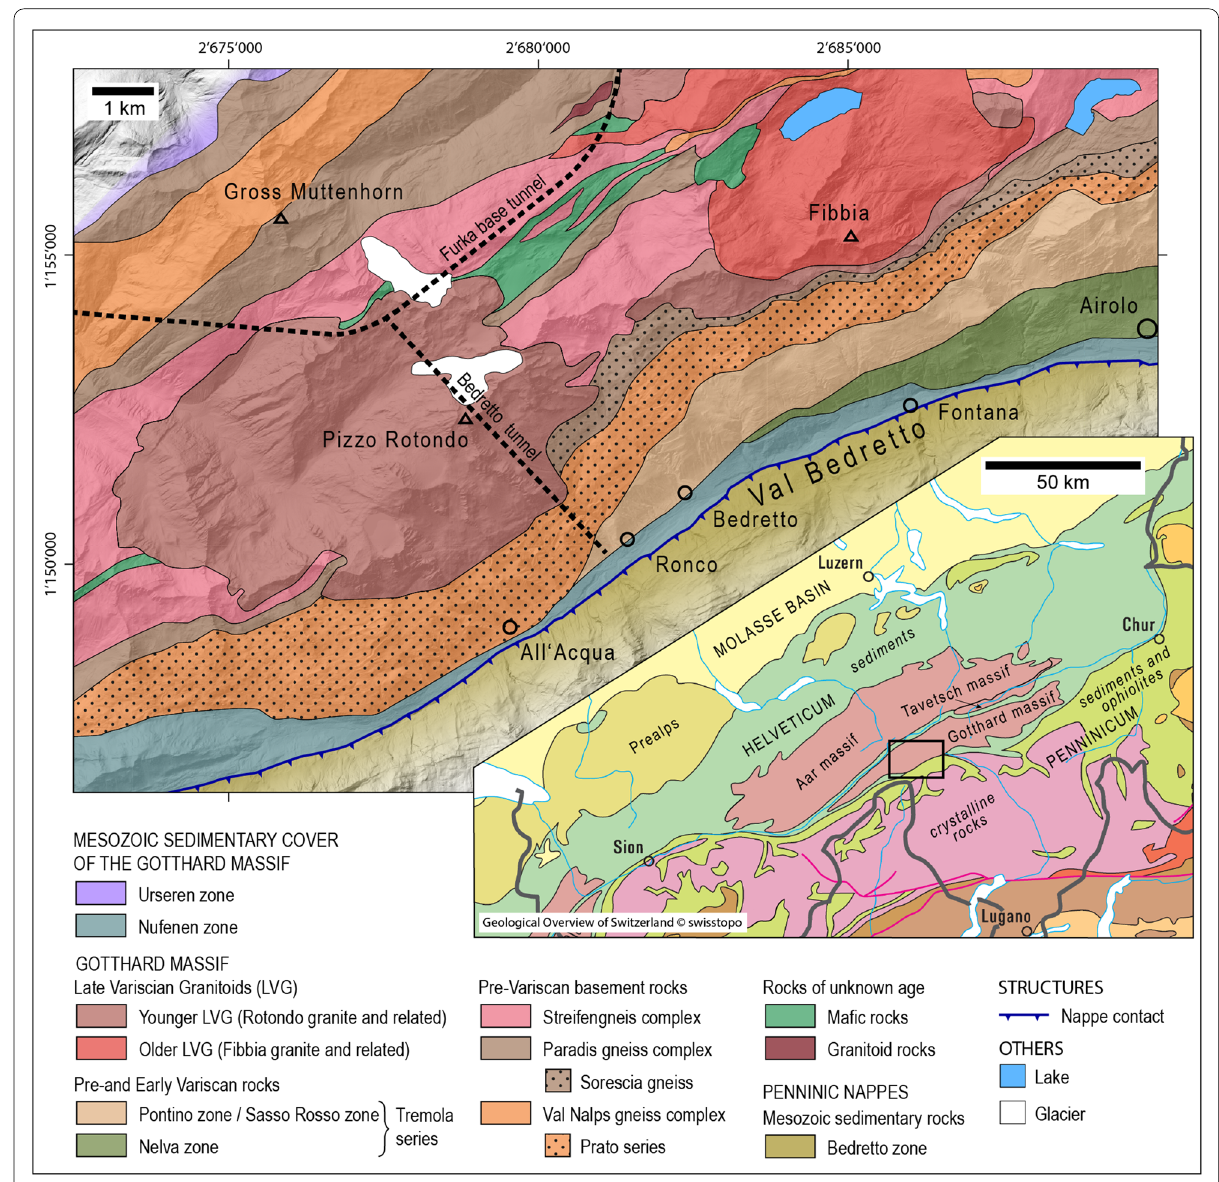
Fig. 1 Main map: geologic overview of the study area (Bedretto tunnel), compiled after Hafner et al. (1975) and Berger et al. (2016). Subunits that are specifically mentioned in the text are highlighted with a dotted signature (Sorescia gneiss and Prato series). Coordinates correspond to the Swiss Grid (CH1903 ). Background hillshade from Federal Office of Topography swisstopo (2011). Bottom right inlet: tectonic overview of the Central Alps + (Federal Office of Topography swisstopo, 2016), black rectangle represents the cutout of the main